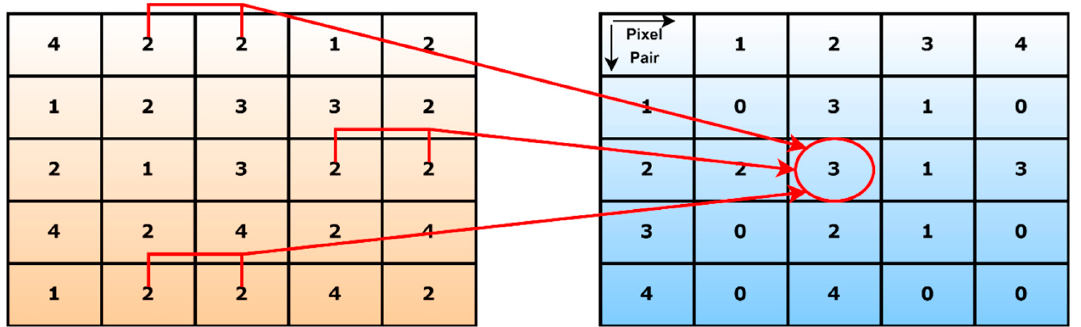
Figure 6. An example of GLCM computation.